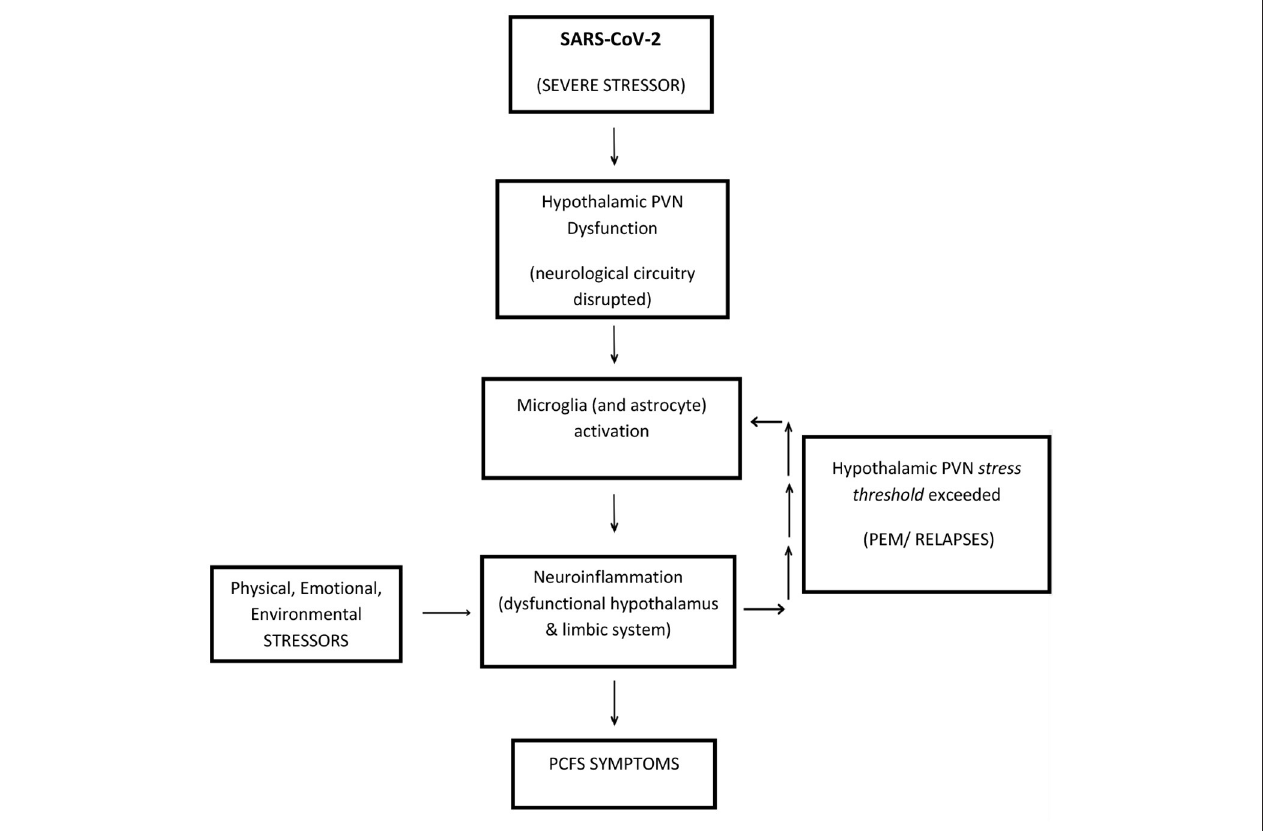
FIGURE 3 | A neuroinflammatory model to explain Post-COVID-19 Fatigue Syndrome (PCFS). SARS-CoV-2 presents as a physiologically SEVERE STRESSOR, which targets the hypothalamic PVN, in genetically susceptible people. The hypothalamic PVN is traumatized into a permanently dysfunctional mode. Ongoing (life) STRESSORS continue to target a now compromised stress-sensitive hypothalamic PVN, causing the perpetuation of PCFS via short-term PEM, or longer-term RELAPSES. Accordingly, a dysfunctional hypothalamic PVN acts as an epicenter to neuroinflammation radiating outwards via localized microglia-induced activation. Resultant dysfunction of the hypothalamus and its surrounding limbic system could account for the majority of symptoms of PCFS. This figure is a modified version of Figure 1 in the study by ( 19) and Figure 1 in the study by